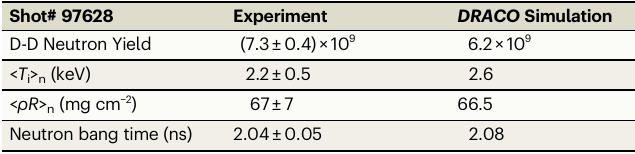
Table 2 | Comparisons of implosion performance between experiment and DRACO